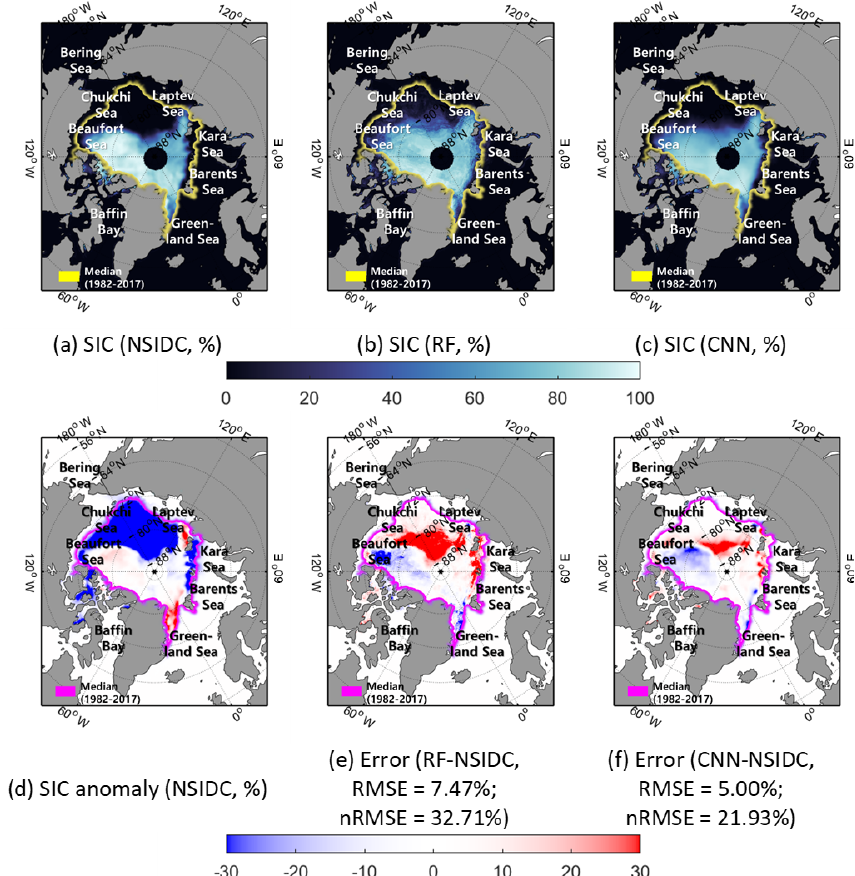
Figure 8. The actual SIC (a) , predicted SICs (b–c) , SIC anomaly (d) , and errors between predicted and the actual SICs (e–f) in Septem- ber